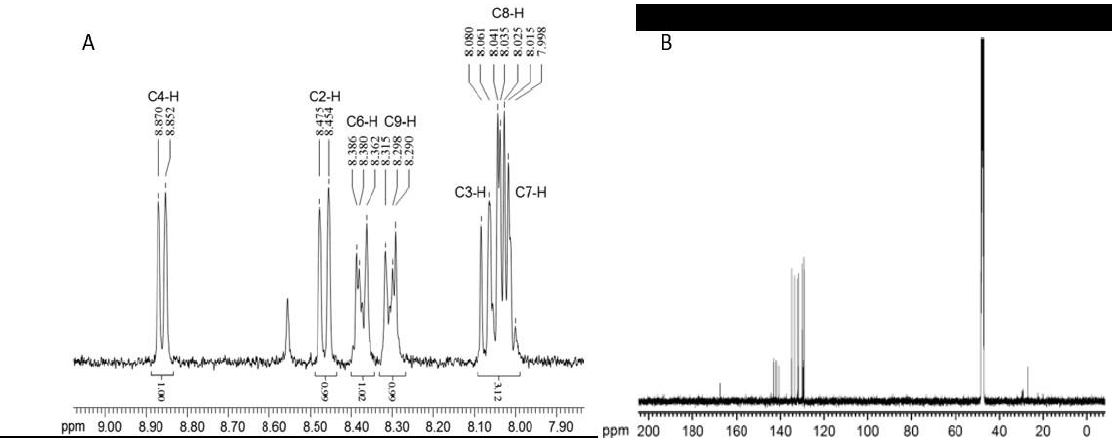
Figure 6. Spectra of PCN phenazine by ( A ) 1 H NMR and by ( B ) 13 C NMR [12].